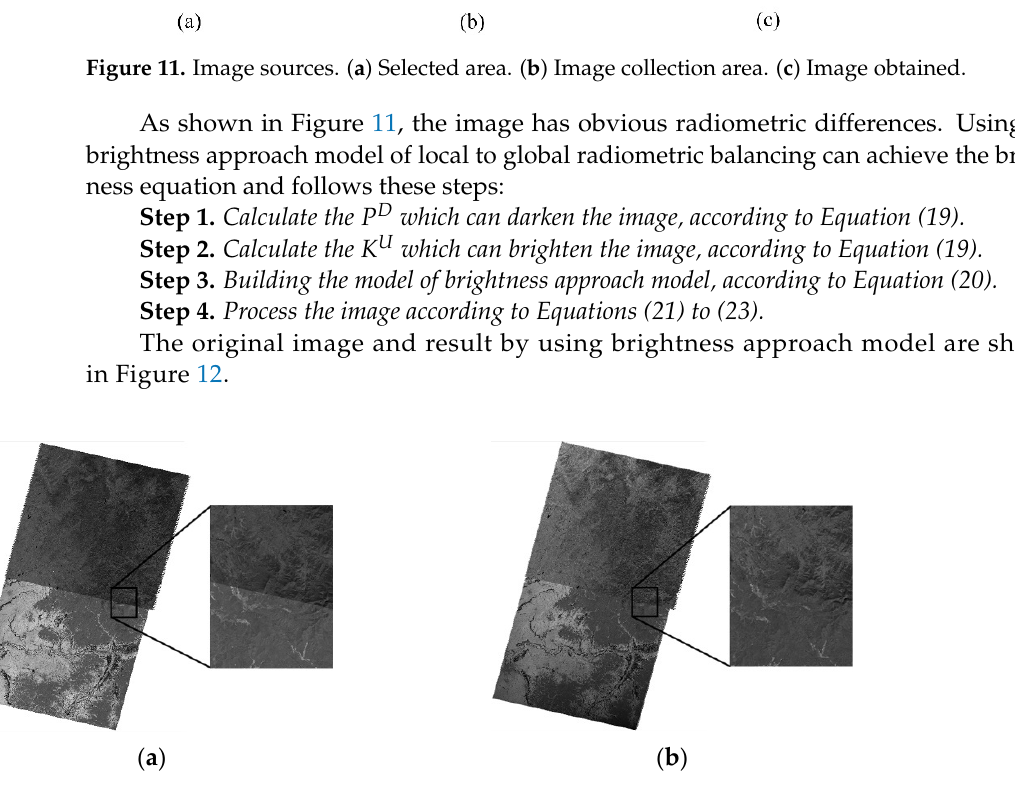
Table 2. The coefficients of variation of each block.